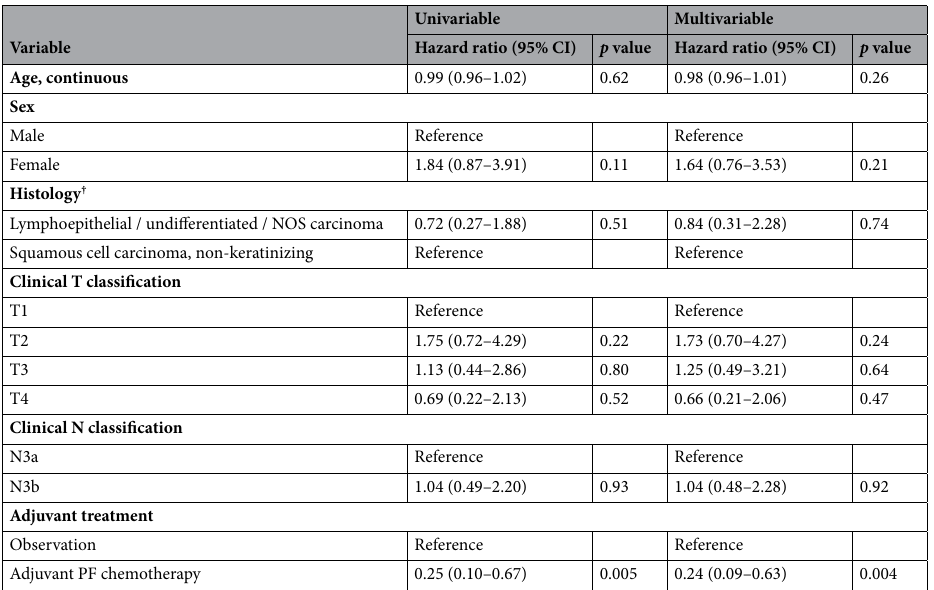
Figure 1. Kaplan–Meier survival curves ( a ) and multivariate adjusted survival curves ( b ) for overall survival show a higher survival rate in the adjuvant PF chemotherapy group. Figure created with R version 3.6.0 (https:// www.r- proje ct. org/).